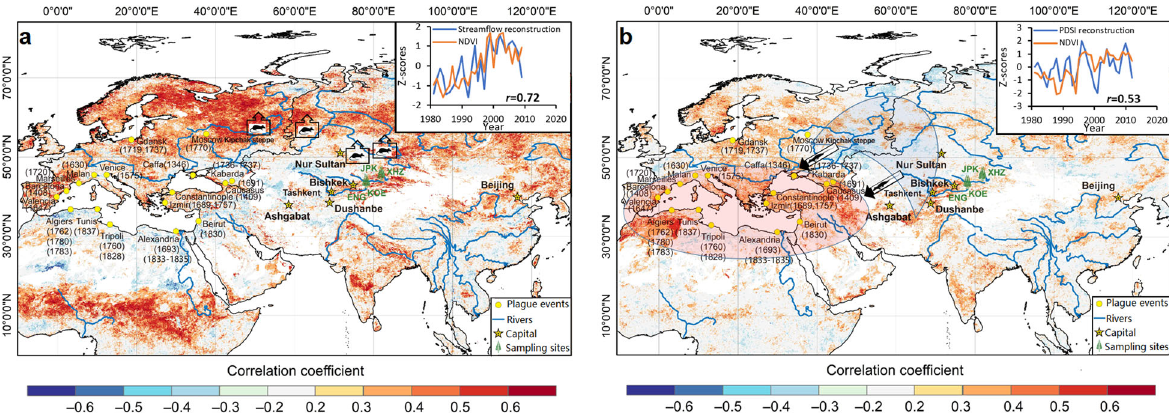
Fig. 3 Spatial correlations between the dendrohydrological reconstructions and the gridded NDVI dataset 62 . a Correlation patterns of the stream fl ow reconstruction with August-October NDVI, a satellite-derived measure of grassland productivity, over their period of overlap (1981 – 2009). Insigni fi cant correlations ( P > 0.05) are masked out. The mouse icons indicate that the rodent population density increased under the good vegetation and water conditions in Central Asia. The inset fi gure shows the comparison between regional NDVI (averaged over 39 – 45°N, 77.5 – 86.5°E) and reconstructed stream fl ow (this study). b Correlation patterns of the PDSI reconstruction of the Mediterranean Basin with July – September NDVI. The mouse icons and arrows show that poor vegetation conditions in Central Asian steppe (blue shape) forced the rodent to migrate to the Mediterranean basin and Western Asia (red circle) with the good vegetation and water conditions. The inset fi gure shows the comparison between regional NDVI (averaged over 30 – 45°N, − 5 – 37°E) and reconstructed PDSI 16 . The numbers in parentheses in the maps indicating the recorded time of plague outbreaks per city.